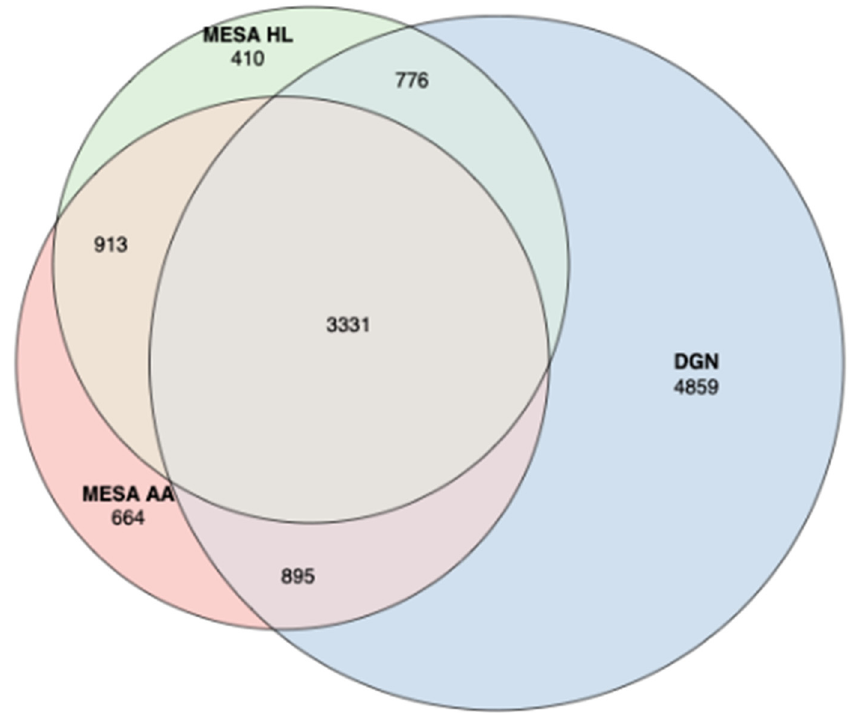
Figure 2. Venn diagram showing the overlap of well-predicted genes by Depression Genes and Networks (DGN) European ancestry and Multi-Ethnic Study of Atherosclerosis (MESA) African ancestry (AA) and Hispanic/Latino (HL) reference panels.